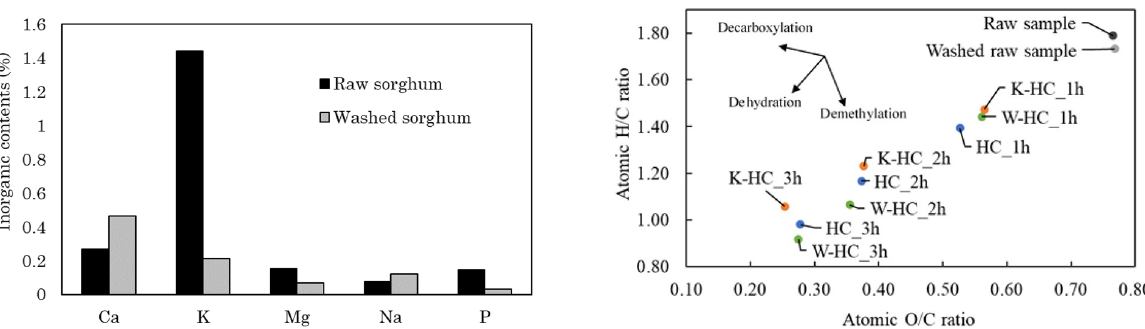
Fig. 1 Percentage of inorganic substances in the raw and washed sorghum as determined by ICP analysis